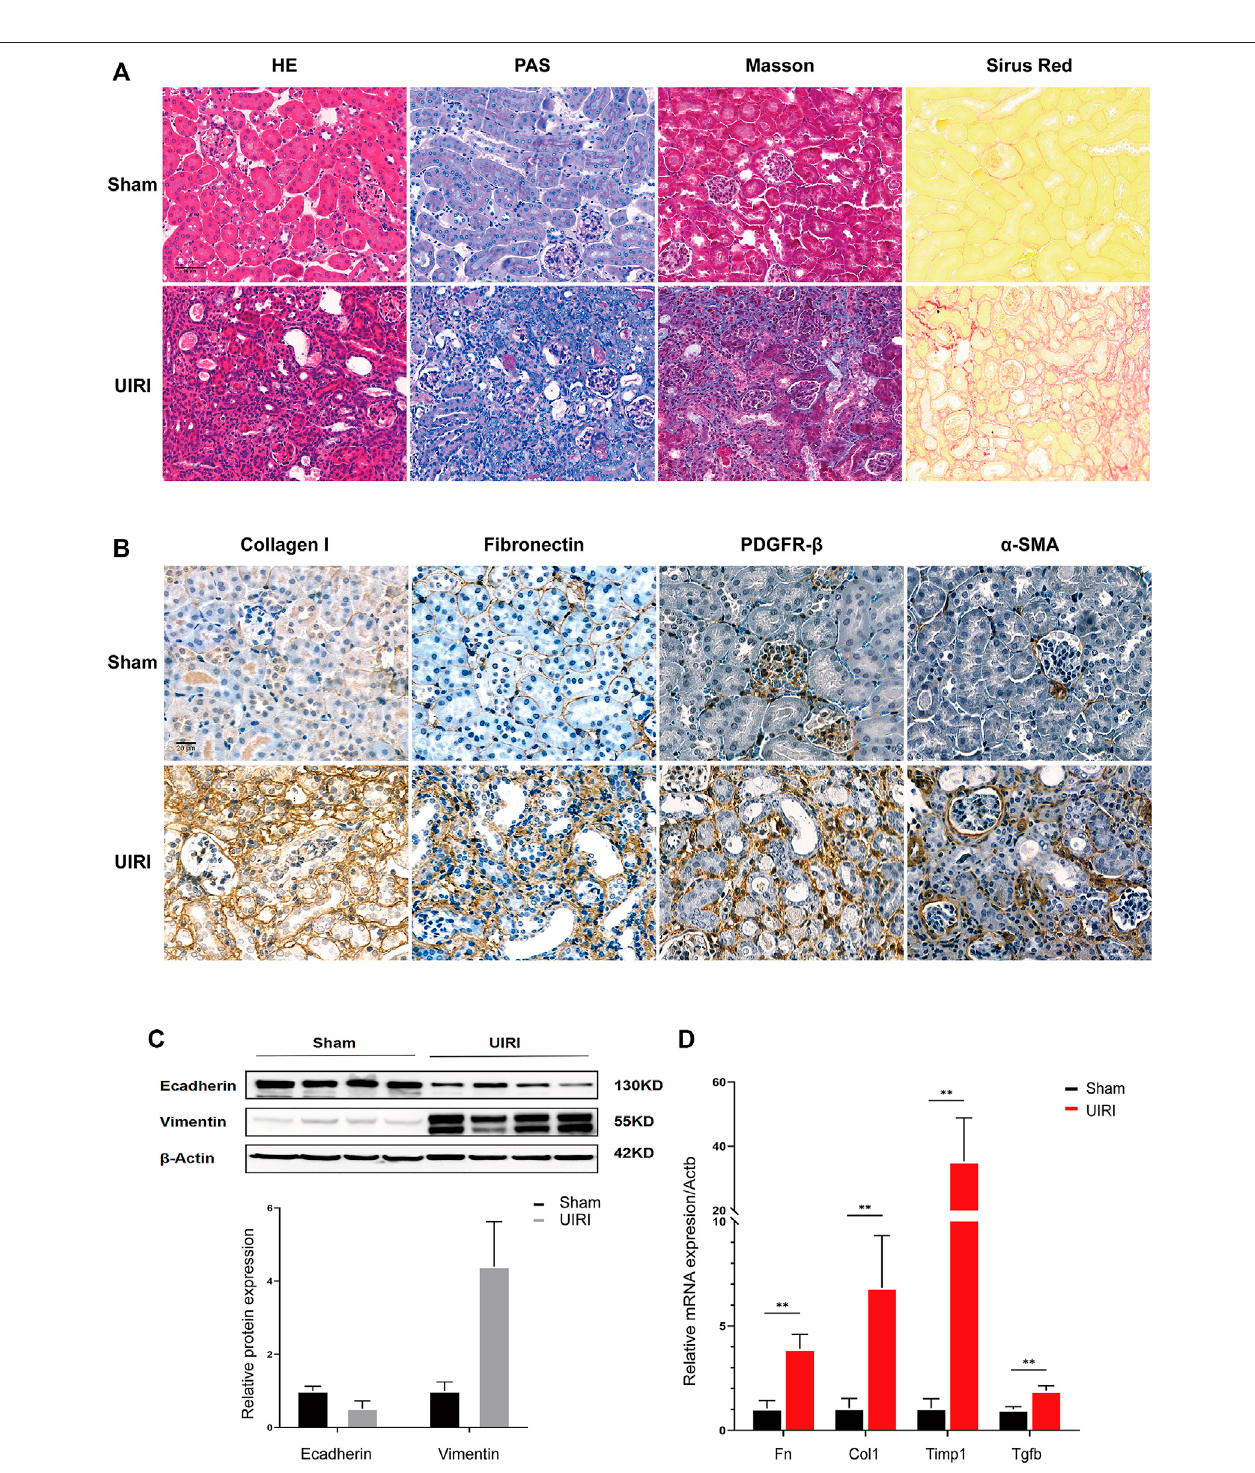
FIGURE 1 | Validation of the transition of UIRI injury to the chronic phase characterized as extensive renal fi brosis. (A) Kidney tissues 14 days after IRI displayed tubular necrosis, atrophy, dilation, cast formation, and in fl ammatory cell in fi ltration in HE and PAS staining. UIRI kidney tissues showed extensive, severe histological deposition of collagen in kidney tissues in Sirius Red and Masson ’ s trichrome staining. (B) Immunohistological staining showed increased collagen I and fi bronectin expression and PDGFR- β +, α -SMA + fi broblasts/myo fi broblasts in kidney tissues after UIRI compared to the sham group. Scale bar = 50 µm. (C) Representative Western blots showing the change in epithelial marker E-cadherin and mesenchymal marker vimentin protein expression in kidney tissues after UIRI. (D) The relative expression levels of fi brotic factors Fn, Col1, Timp1, and Tgfb by the RT – qPCR. ** p < 0.01 vs. sham group. Fn, fi bronectin; Col1, collagen I; Timp1, tissue inhibitor of metallopoteinase 1; Tgfb, transforming growth factor-beta.